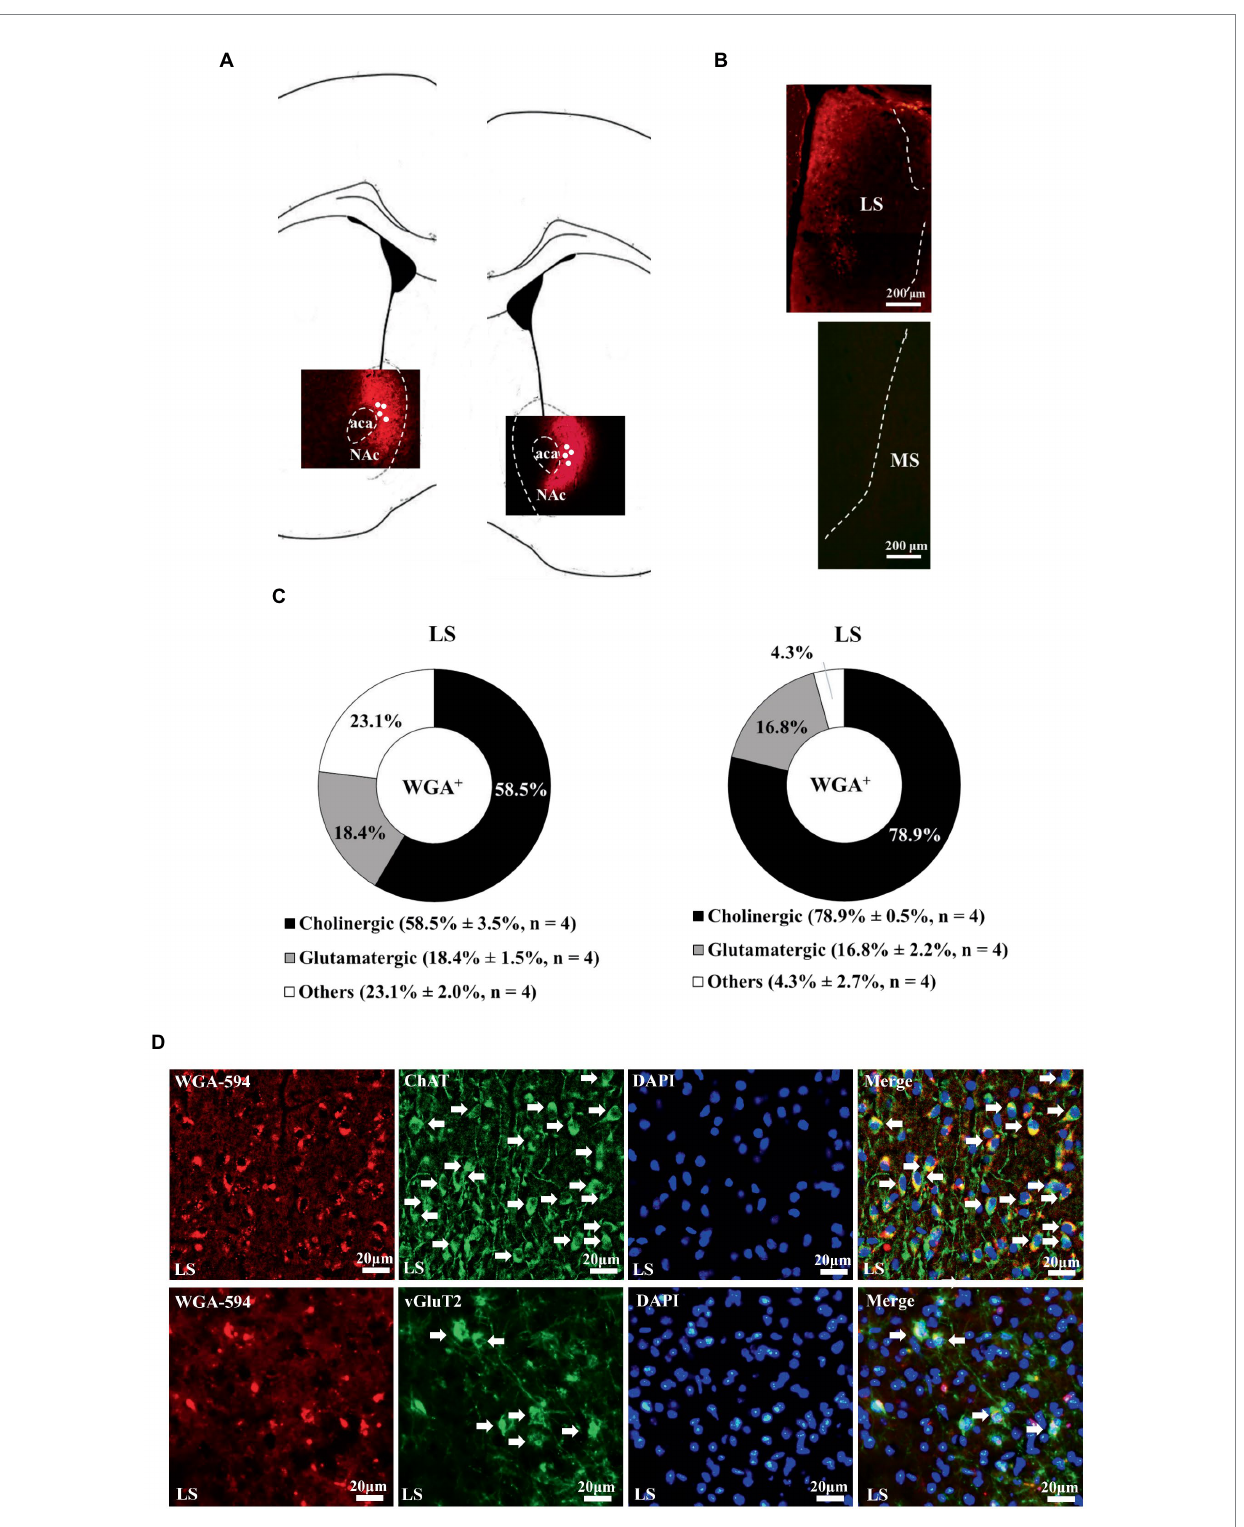
FIGURE 1 Unilateral accumbal WGA-AF594 infusion was retrograde traced to cholinergic neurons in ipsilateral dorsal lateral septum. (A) Schematics of nucleus accumbens (Acb) and representative unilateral WGA-AF594 infusion (red) sites in medial and lateral part of Acb. Solid white circles stand for injection site. (B) Representative photomicrographs showing WGA-positive (red) spots in lateral septum (LS) but not medial septum (MS). (C) Pie charts for cholinergic, glutamatergic and other neurons of WGA-positive spots in dorsal lateral septum in intra-medial (left panel) and lateral (right panel) Acb WGA infusions. Mean ± SEM is shown. (D) Upper panel: representative photomicrographs of WGA + (red), ChAT + (green), DAPI + (blue), and (WGA/ChAT/ DAPI) + (indigo center, yellow surround) neurons in lateral septum. Lower panel: representative photomicrographs of WGA + (red), vGluT2+ (green), DAPI + (blue), and (WGA/vGluT2/DAPI) + (indigo center, yellow surround) neurons in lateral septum. White arrows annotate positive cells. ChAT and vGluT2 are short forms of choline acetyl-transferase and vesicular glutamate transporter 2. Scale bar = 20 μ